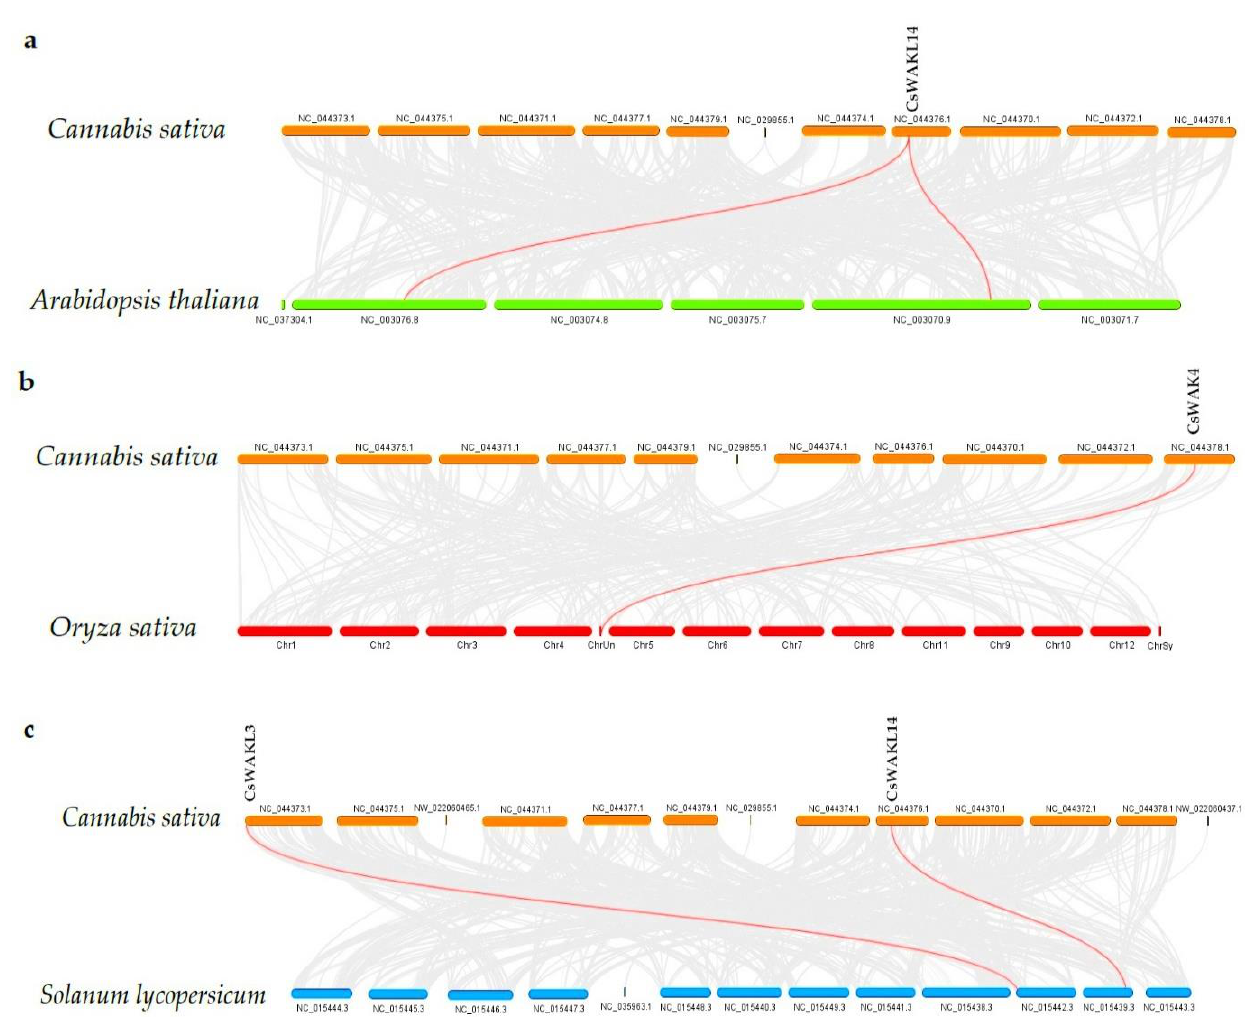
Figure 5. Synteny analysis of WAK/WAKL genes between Cannabis sativa and Arabidopsis thaliana ( a ); C. sativa and Oryza sativa ( b ); and C. sativa and Solanum lycopersicum ( c ). The red lines represent the syntenic WAK/WAKL gene pairs, whiles the grey lines represent the syntenic blocks within the two genomes.